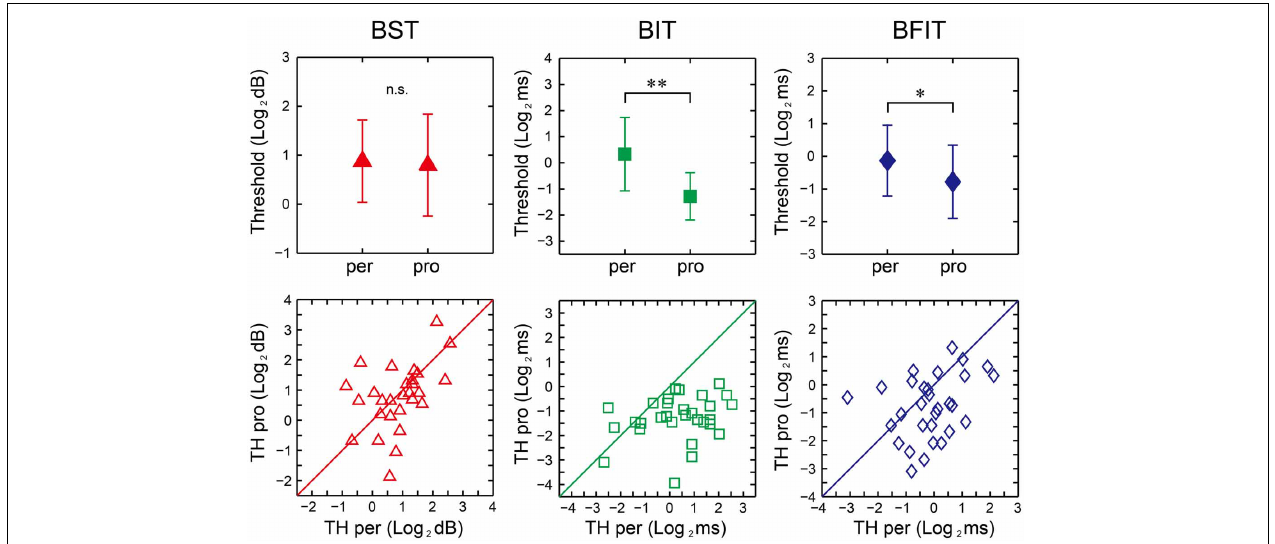
FIGURE 11 | Mean (upper) and distribution (lower) of the thresholds across 30 participants in beat saliency test (BST), beat interval test (BIT), and beat finding and interval test (BFIT). The error bars indicate the